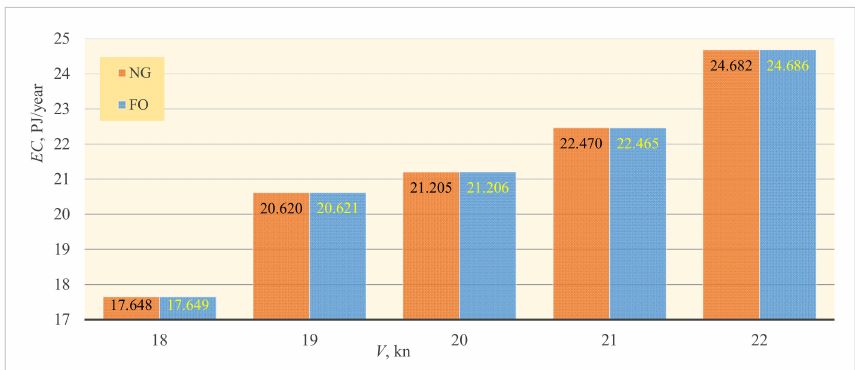
Figure 29. The comparison of annual energy consumption between FO- and NG-fueled mode.